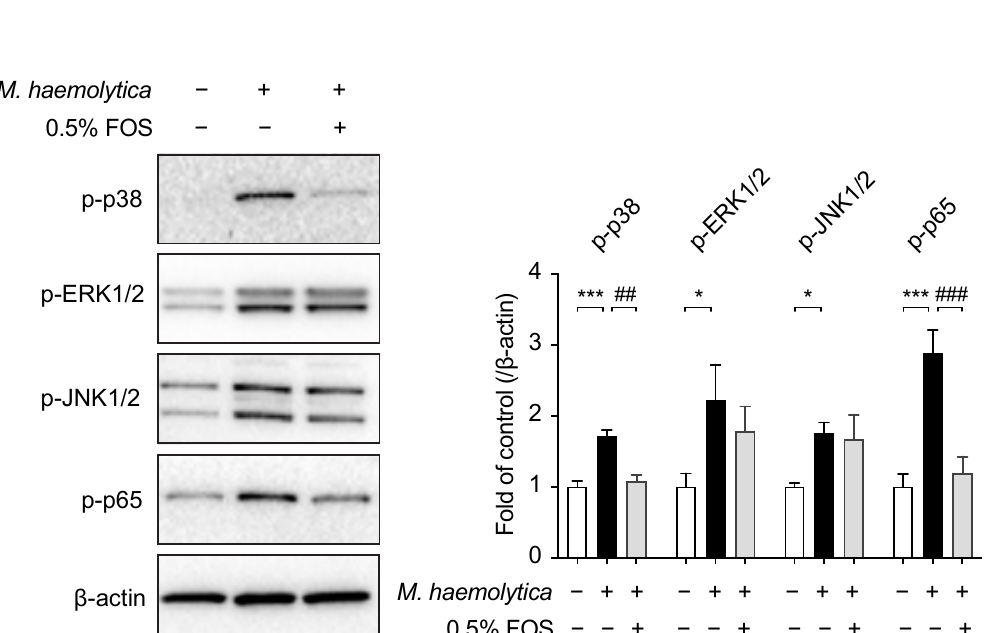
Figure 6. Effect of FOS on M. haemolytica -induced phosphorylation of MAPK and NF- κ B p65 in PBECs. Phosphorylation of p38, ERK1/2, JNK1/2 MAPK and NF- κ B p65 were determined by immunoblot and results were shown as a fold of control. Significantly different from control: * p < 0.05; *** p < 0.001. Significantly different from M. haemolytica : ## p < 0.01; ### p < 0.001. Data are presented as means ± SEM. All data shown are representative of five independent experiments ( n = five donor calves, one donor calf per experiment). ERK, extracellular signal-regulated kinase; FOS, fructo-oligosaccharides;